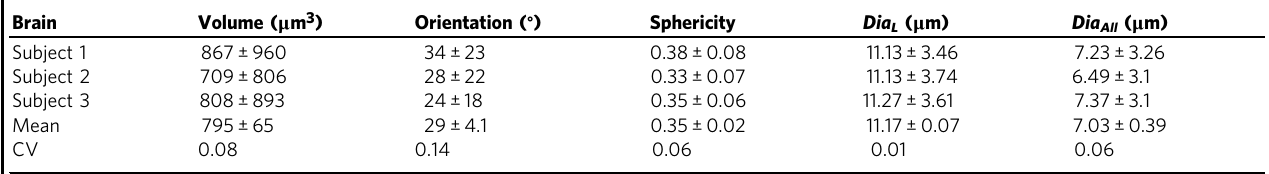
Table 4 Quantitative values for pyramidal neurons from the entire stack of each